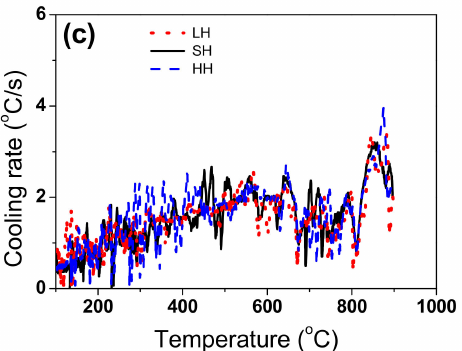
Figure 7. Comparison of cooling rate at the center areas of the Jominy specimen with the water jet height as a function of region: ( a ) 5 mm, ( b ) 40 mm, and ( c ) 85 mm from the quenched end (QE).